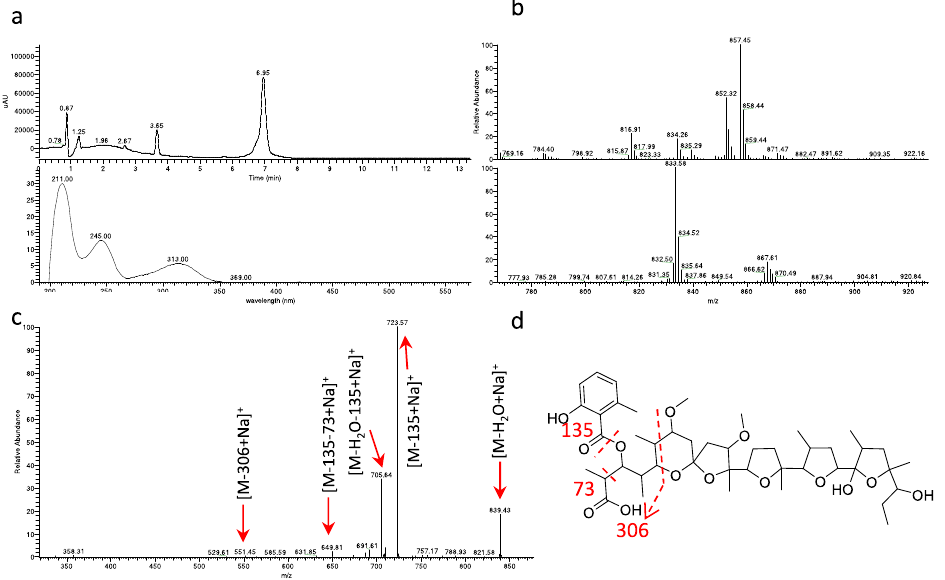
Figure 5. Analysis of α -770. ( a ) UV chromatogram at 230 nm and UV spectrum of 6.9-min peak. Data obtained with a partially purified extract of Actinoallomurus sp. ID145770; ( b ) MS at 6.9 min in positive (above) and negative (below) ionization mode; ( c ) MS 2 of m/z [M+NH 4 ] + 852; ( d ) putative fragmentation pathway for α -770.